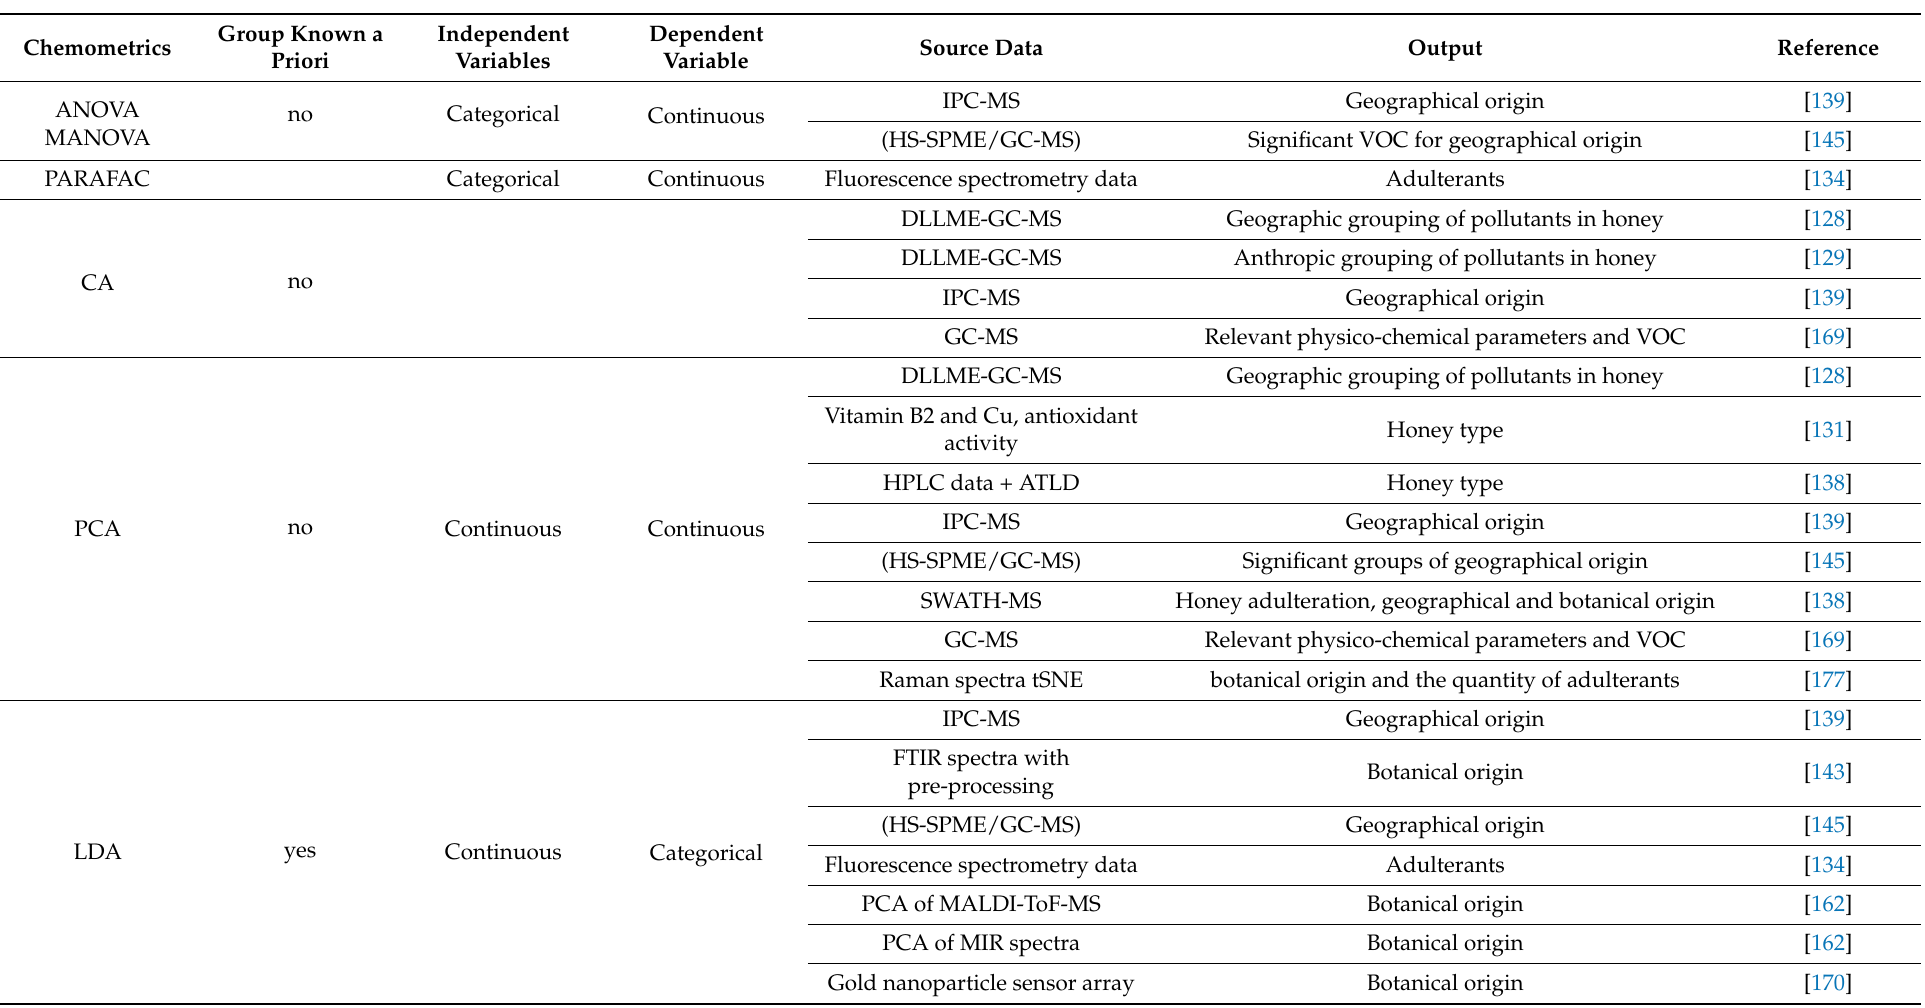
Table 2. Chemometrics used in the honey quality